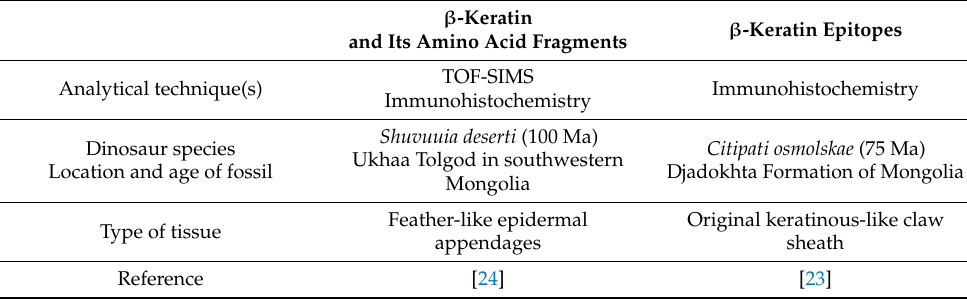
Table 4. Evidence of beta-keratin in the dinosaur fossil record.